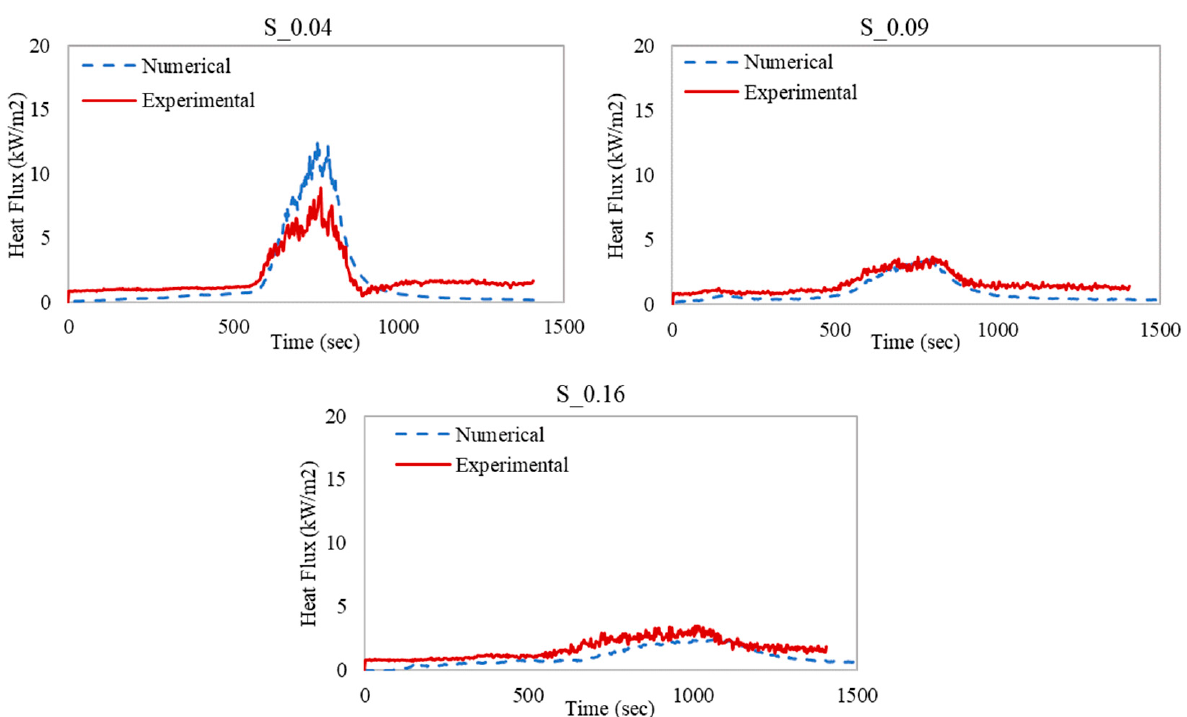
Figure 21. Radiative heat flux (slot cases). (Due to technical issues S_0.01 was not recorded).